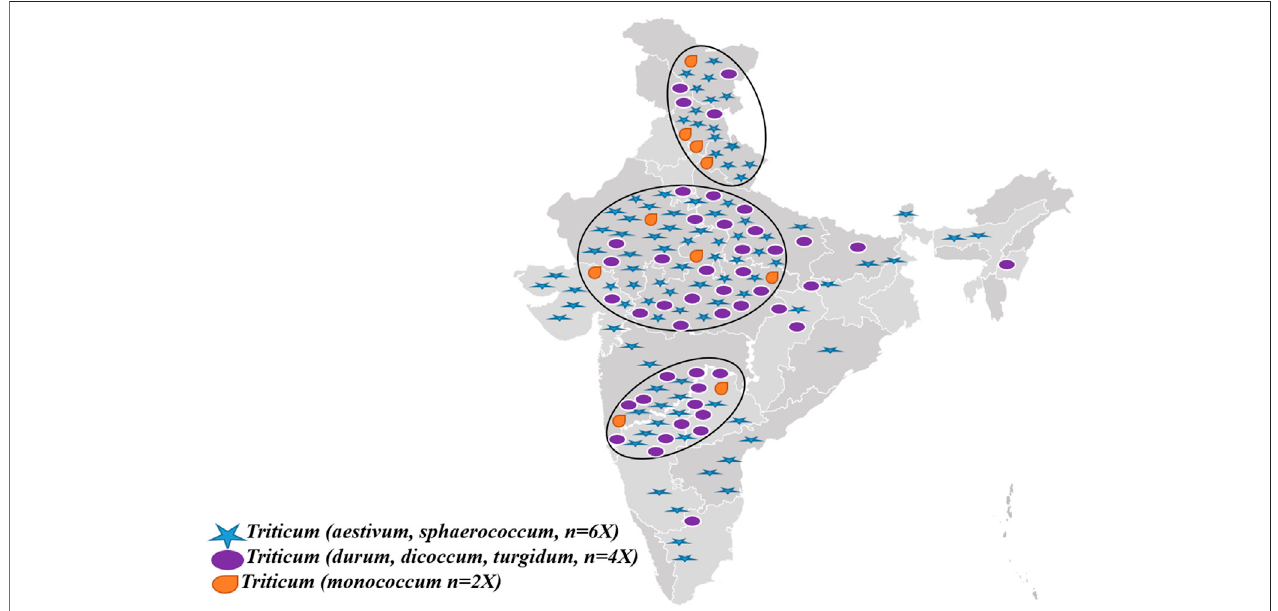
FIGURE 2 | Prevalence and collection sources of diverse ploidy wheat genetic resources in India.